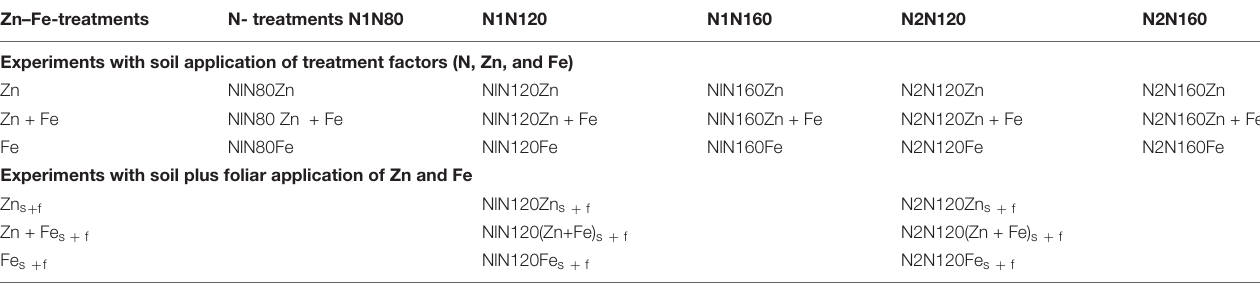
TABLE 1 | Design of experiment and rate of fertilization as per